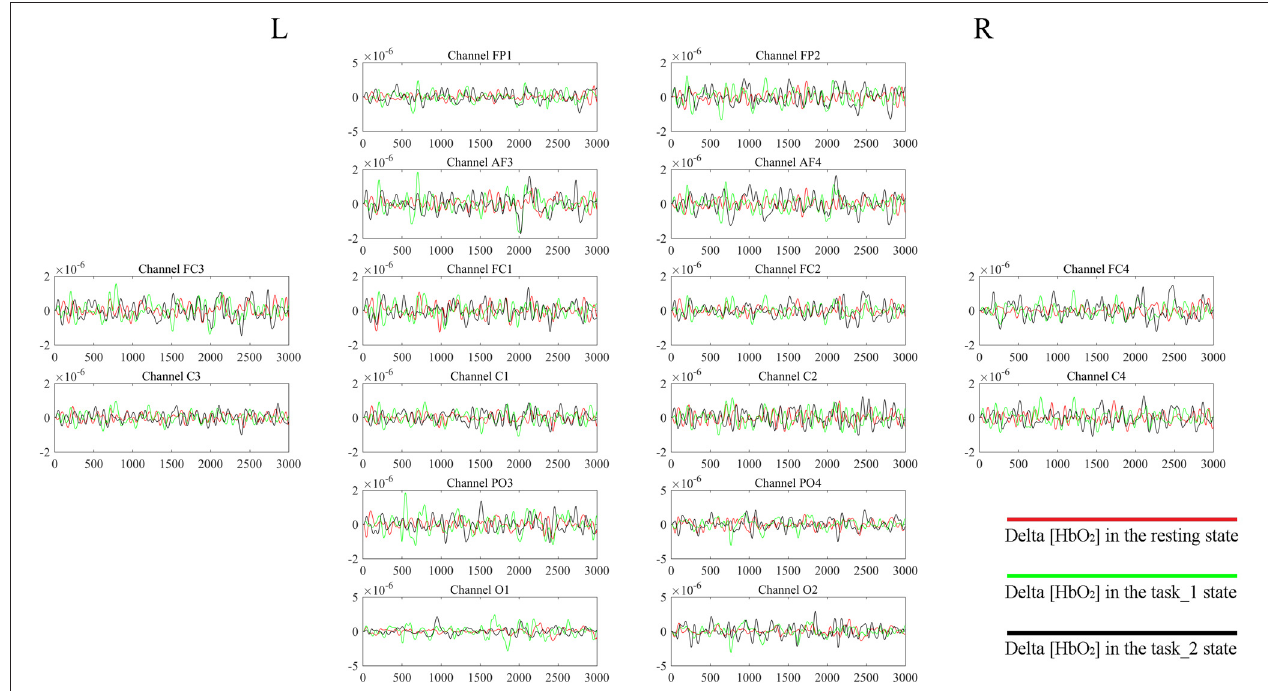
FIGURE 4 | Delta [HbO 2 ] signals of one subject. The distribution of the channels is the same as that in Table 1 and Figure 2 . For each channel, the horizontal X -axis shows the time and the vertical Y -axis shows the delta [HbO 2 ] signals. The signals of different colors represent different delta [HbO 2 ] signals in different states.